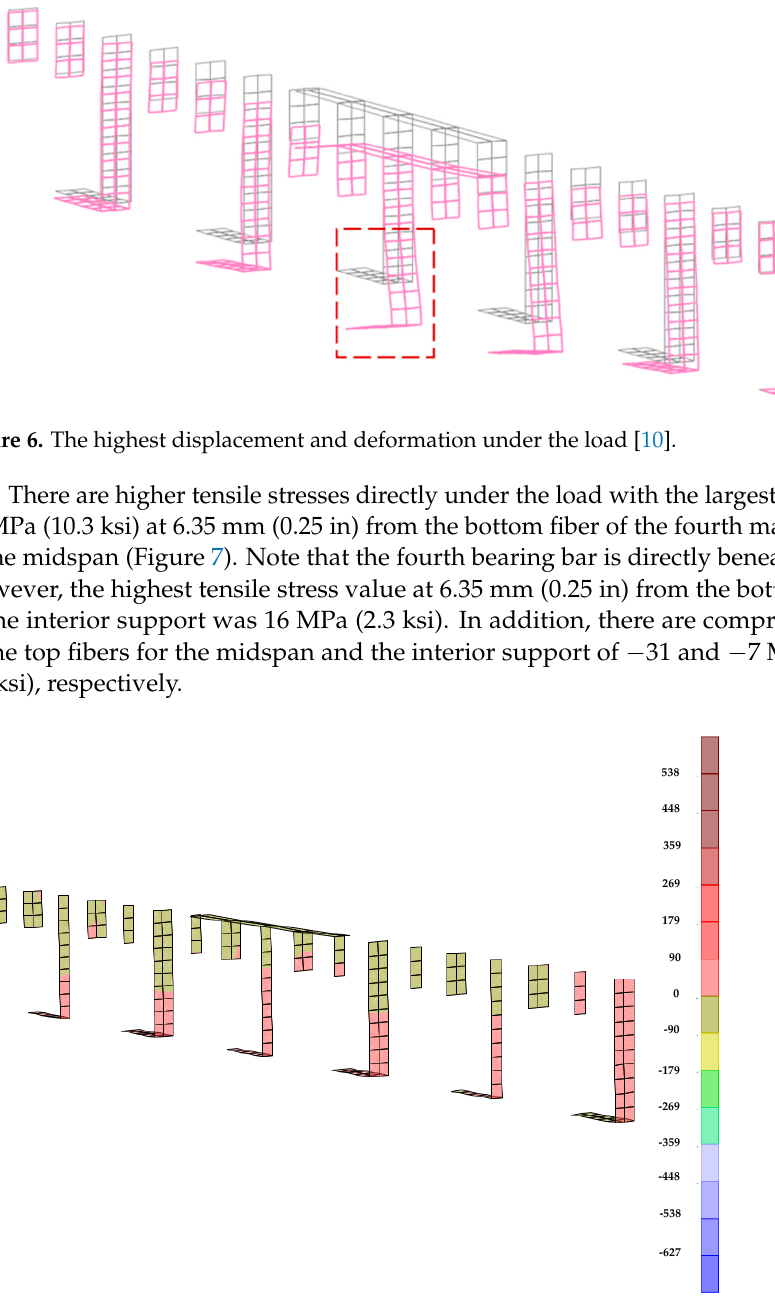
Figure 7. Tensile stresses along the bottom of the midspan [10]. Table 1 provides a summary of the stresses located 6.35 mm (0.25 in) from the top and bottom of the main bearing and intermediate bars along the midspan of the grate, for the span loaded by Tire Patch 1. The location for reporting tensile stresses corresponds to strain gage measurements taken during an earlier experimental study